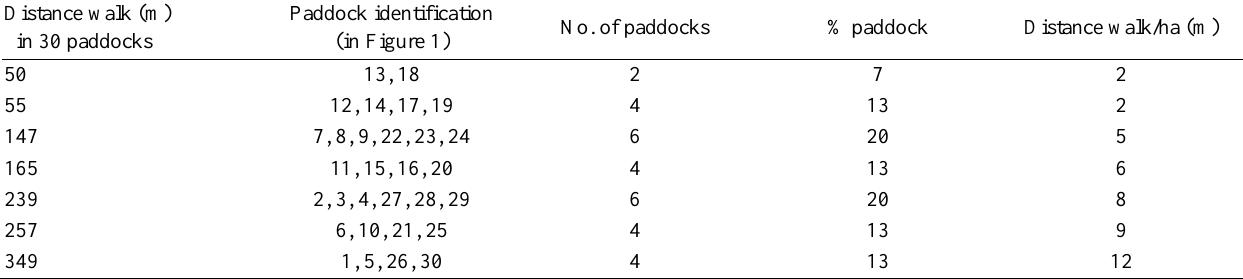
Distance walk (m) in 30 paddocks